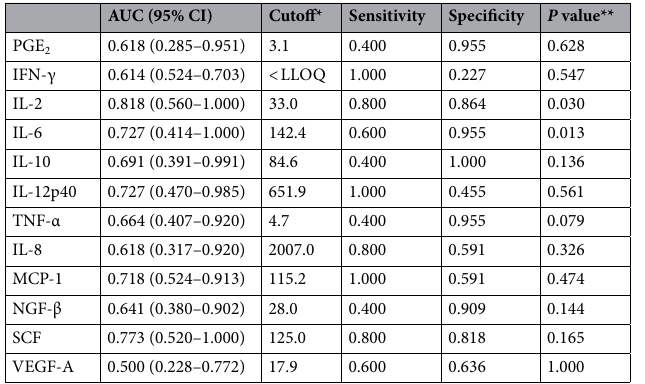
Table 2. ROC analysis of each serum factor in relation to tumor response. The sensitivity and specificity of each factor to predict tumor response are shown. AUC, area under the curve; CI, confidence interval; LLOQ, lower limit of quantification. *Cutoffs were determined by calculating the Youden’s index. **Fisher’s exact test.